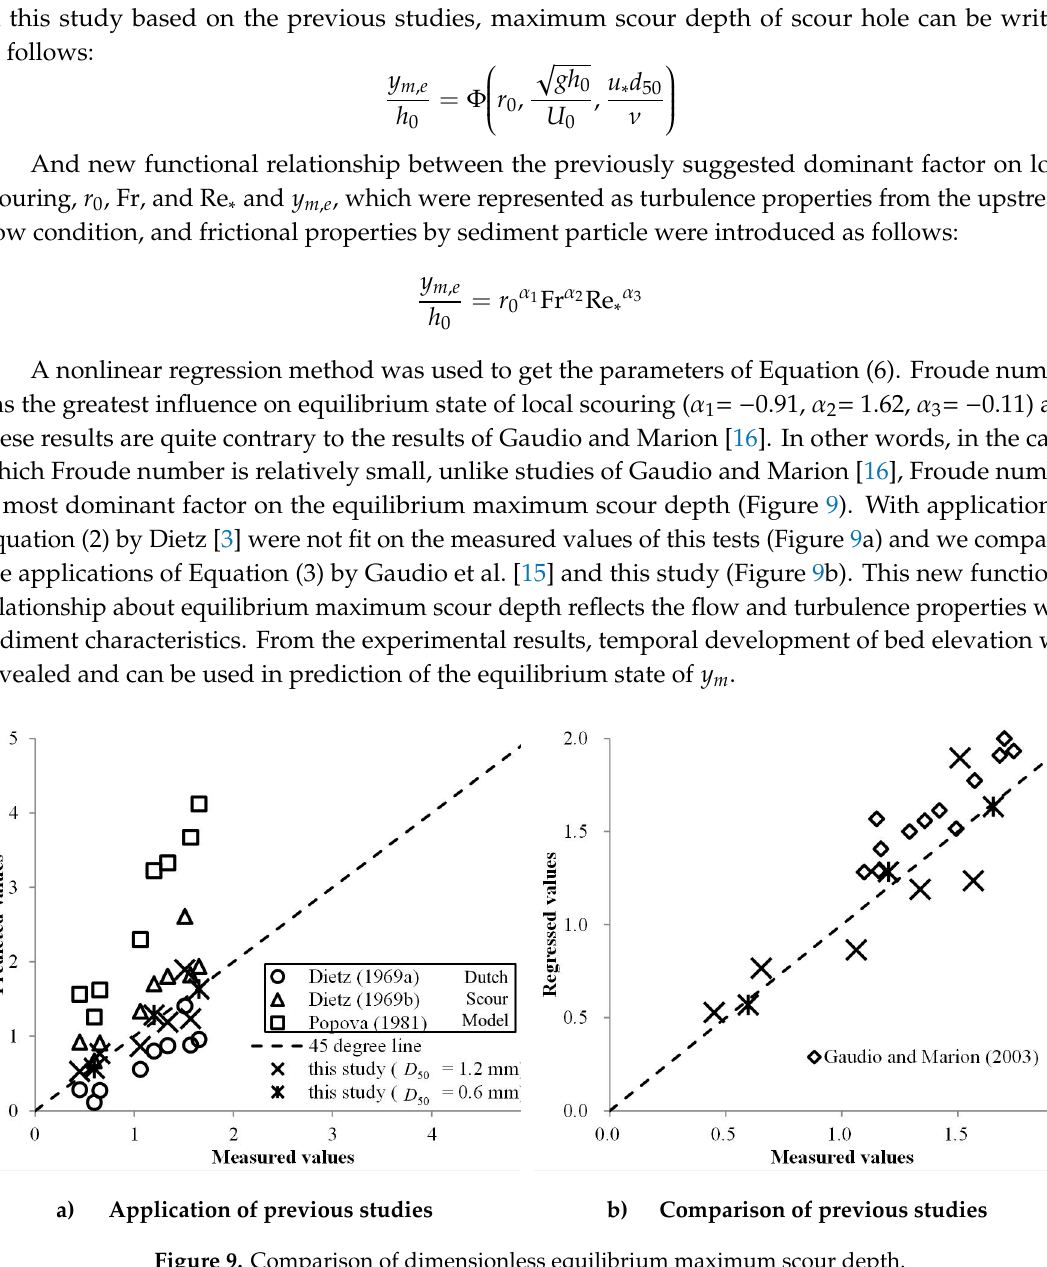
Figure 9. Comparison of dimensionless equilibrium maximum scour depth.